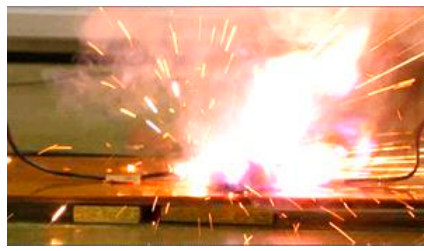
Figure 8. Ignition of combustibles.